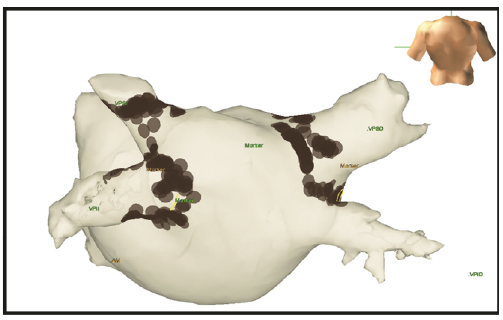
Figure 1: Electroanatomic map after atrial fibrillation